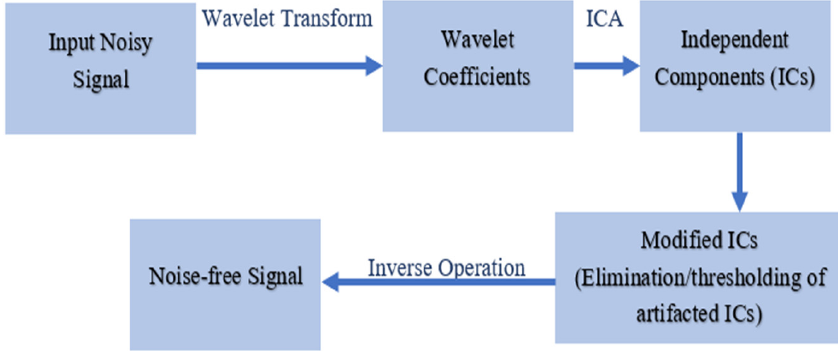
Figure 5. Basic flow chart of wavelet-ICA based EEG denoising.